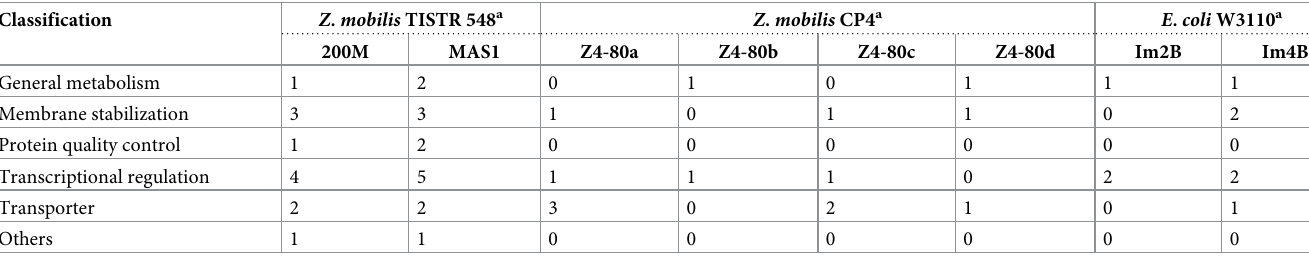
Table 2. Classification of mutated genes in thermoadapted